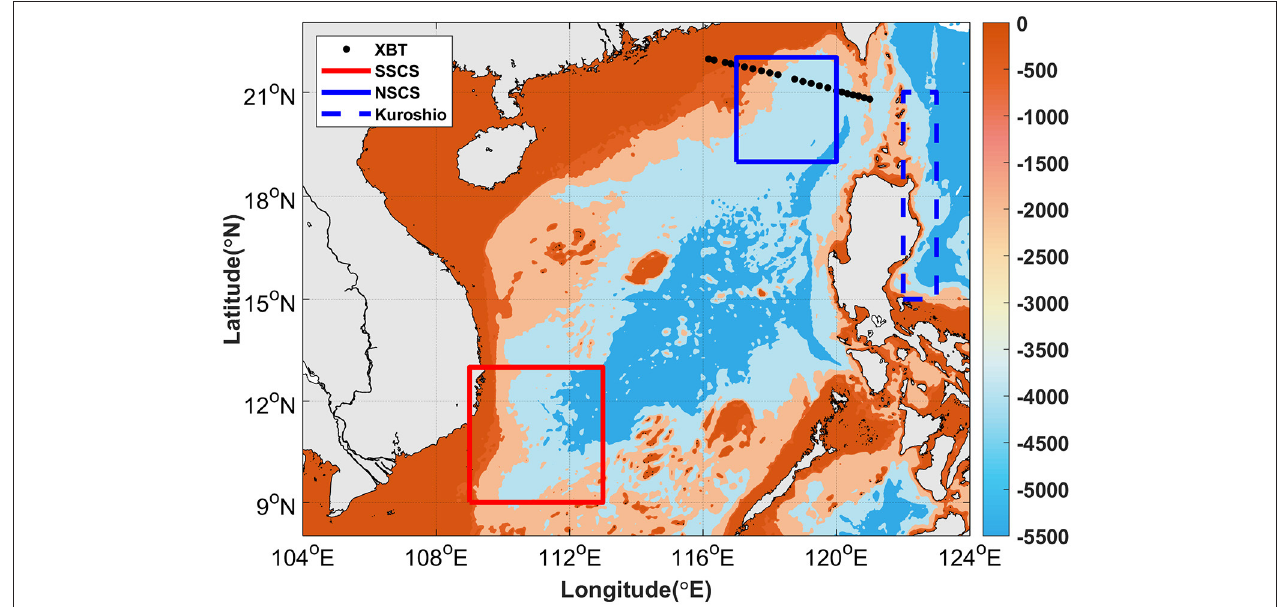
FIGURE 1 | Bathymetry in the South China Sea (SCS). The black dots show the PX44 transect, which is the repeated hydrographic surveys of expendable bathythermographs (XBTs). The solid blue, dashed blue, and solid red rectangles show the region of northern South China Sea (NSCS), Kuroshio, and southern South China Sea (SSCS) used to show the long-term temperature-salinity (TS) properties of